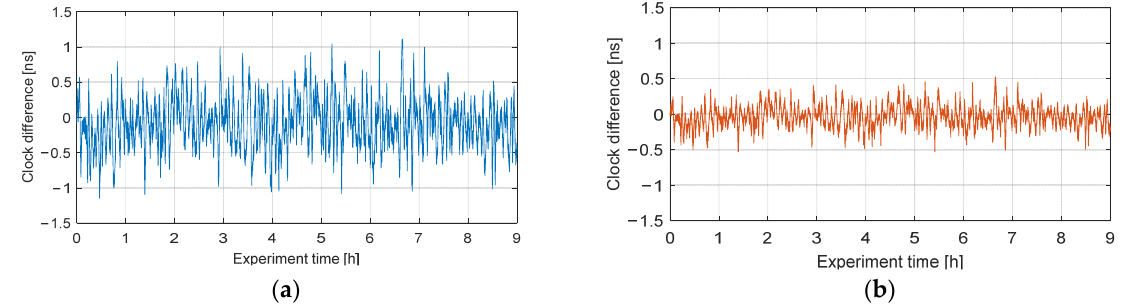
Figure 9. Clock difference of two schemes ( a ) without temperature tracking and ( b ) with temperature tracking.